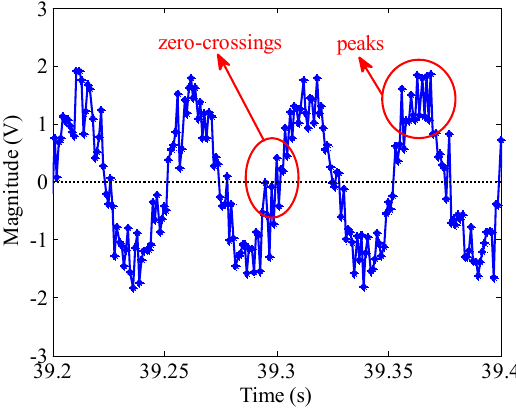
Figure 9. The time domain waveform of x ( t ) at a 9-dB SNR.